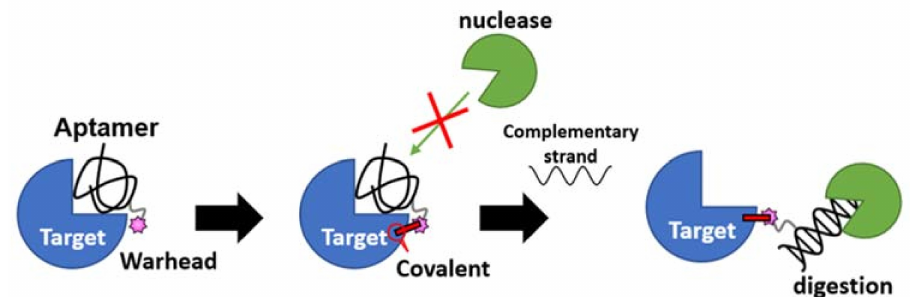
Figure 8. A reversible antidote mechanism of nucleotidic TCI. Once the irreversible covalent bond is formed on the target, the aptamer becomes nuclease (green packman) resistance. When the aptamer is dislodged from the binding site by the on-demand addition of the complimentary strand antidote, it becomes sensitive to nuclease digestion even though still covalently bound to the